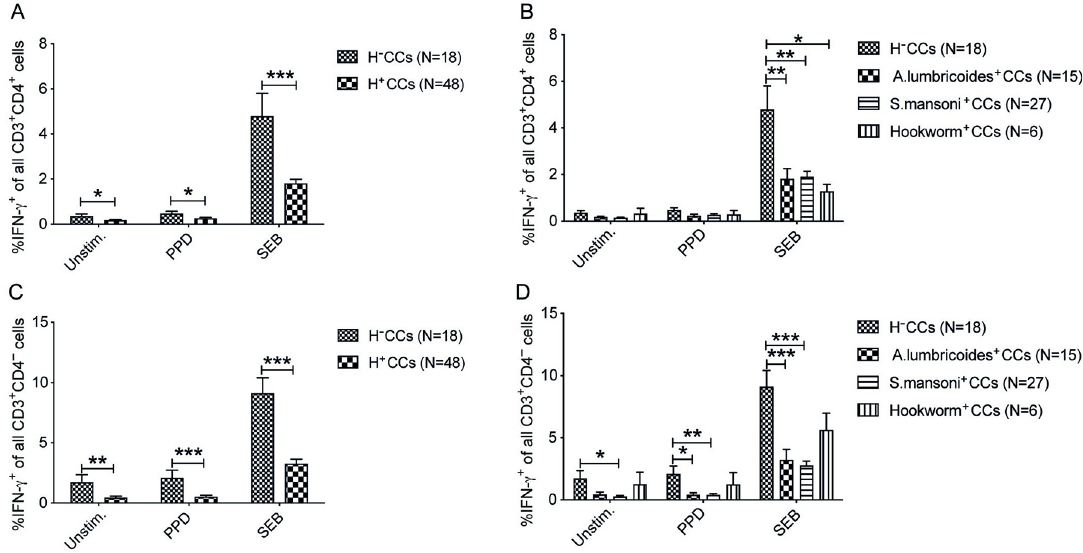
Fig 2. Helminth infection decreases IFN- γ producing capacity of T cells in QFT - CCs. PBMCs from community controls (QFT - CCs) with and without helminth infection were ex vivo stimulated with PPD, SEB, or left unstimulated (Unstim.) and incubated with Brefeldin A for flow cytometry analysis of intracellular IFN- γ expression in CD3 + T cells. Frequency of IFN- γ + CD4 + T cells of all CD3 + CD4 + cells in helminth negative (H - CCs) and combined helminth positive (H + CCs) (A), H - and specific helminth infection ( A . lumbricoides + , S . mansoni + and hookworm + ) (B). Frequency of IFN- γ + CD4 - T cells of all CD3 + CD4 - cells in H - CCs versus H + CCs (C) and H - CCs versus specific helminth infection (D). Data presented as mean ± SEM and the unpaired two-sided Student’s t-test was used to analyze the differences between H - and combined H + CCs, whereas one-way ANOVA following Tukey’s multiple comparison test was used to test the species-specific effect. � , p < 0.05; �� , p < 0.01; ��� , p <